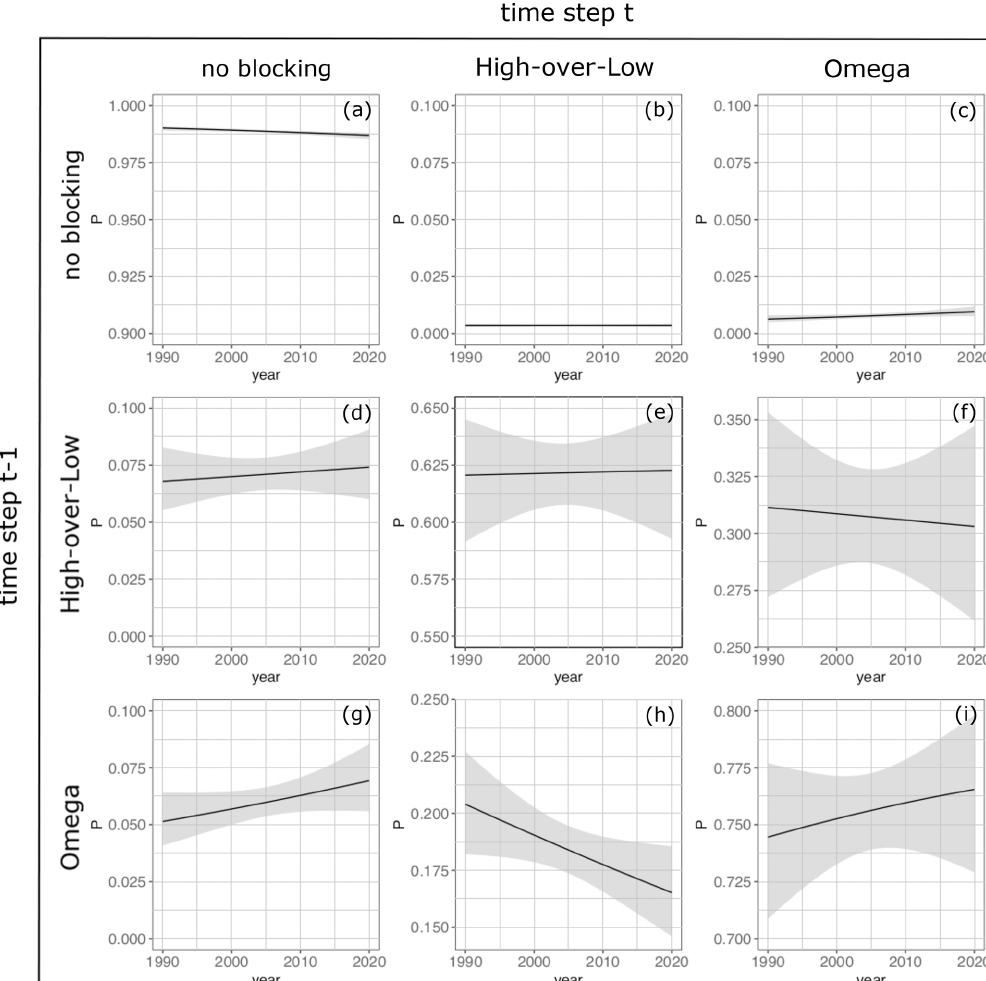
Figure 13. Transition probabilities analogous to the matrix of a three-state Markov process (Eq. 18) as a function of years (Eq. 29) in the Euro-Atlantic region (40 ◦ W–30 ◦ E); (a) p nB | nB , (b) p HoL | nB , (c) p (cid:127) | nB , (d) p nB | HoL , (e) p HoL | HoL , (f) p (cid:127) | HoL , (g) p nB | (cid:127) , (h) p HoL | (cid:127) and (i) p (cid:127) | (cid:127) . Shading shows 95% confidence